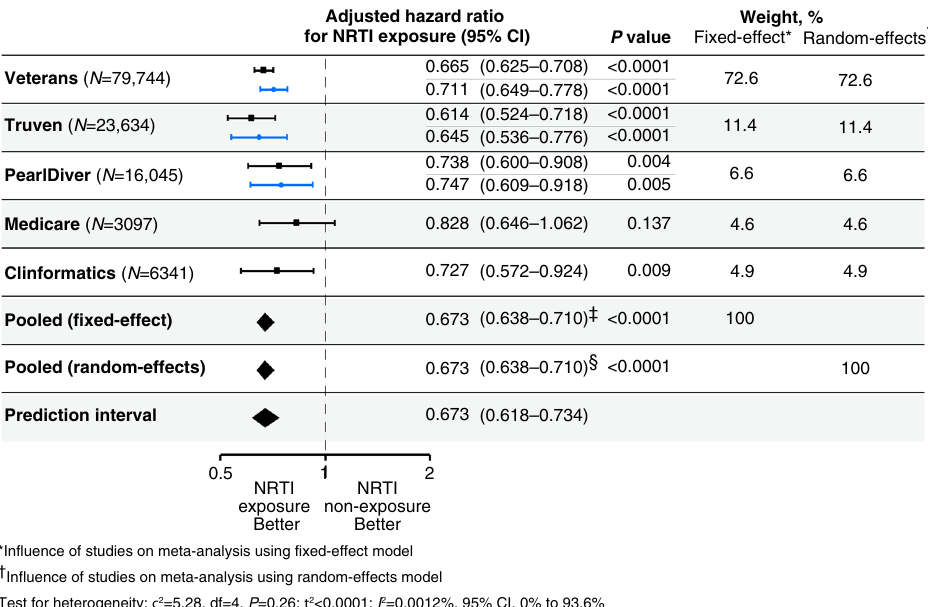
*Influence of studies on meta-analysis using fixed-effect model †Influence of studies on meta-analysis using random-effects model Test for heterogeneity: c 2 =5.28, df=4, P =0.26; t 2 <0.0001; I 2 =0.0012%, 95% CI, 0% to 93.6% ‡Test for overall effect: z =14.61, P <0.0001 §Test for overall effect: z =14.61, P <0.0001 Fig. 1 Forest plot of incident diabetes. Hazard ratios based on a Cox proportional-hazards model and adjusted for the confounding variables listed in Supplementary Tables 5, 7, 9, 11, and 13 were estimated separately for each database. The dashed vertical line denotes a hazard ratio of 1.0, which represents no difference in risk between nucleoside reverse-transcriptase inhibitor (NRTI) exposure and non-exposure. The black horizontal bars represent 95% con fi dence intervals (CI) for unmatched models. The blue horizontal bars represent 95% CI for propensity score-matched models. P values derived from z tests for individual databases are reported. Inverse-variance-weighted random-effects and fi xed-effect meta-analyses were performed to obtain a pooled estimate of the adjusted hazard ratio of incident diabetes for NRTI exposure (ever versus never). The prediction interval is reported. The estimate of heterogeneity ( τ 2 ) and the results of the statistical test of heterogeneity using the chi-square ( χ 2 ) test statistic and its degrees of freedom (df) are shown below the plot. The Higgins I 2 statistic and its 95% CI are presented. The results of the statistical tests of overall effect, the z test statistics, and corresponding P values are presented. All tests were